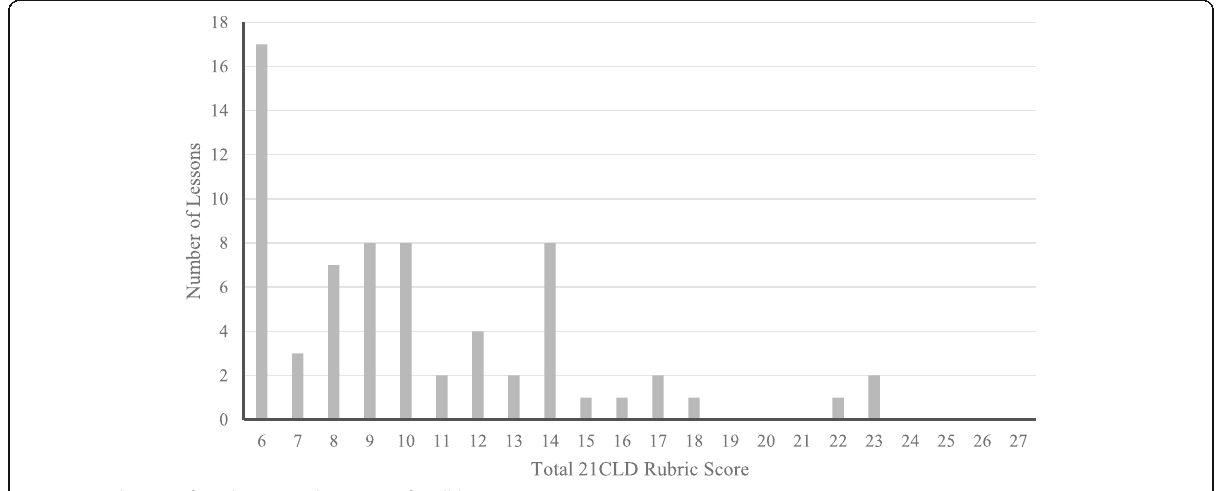
Fig. 2 Distribution of total 21CLD rubric scores for all